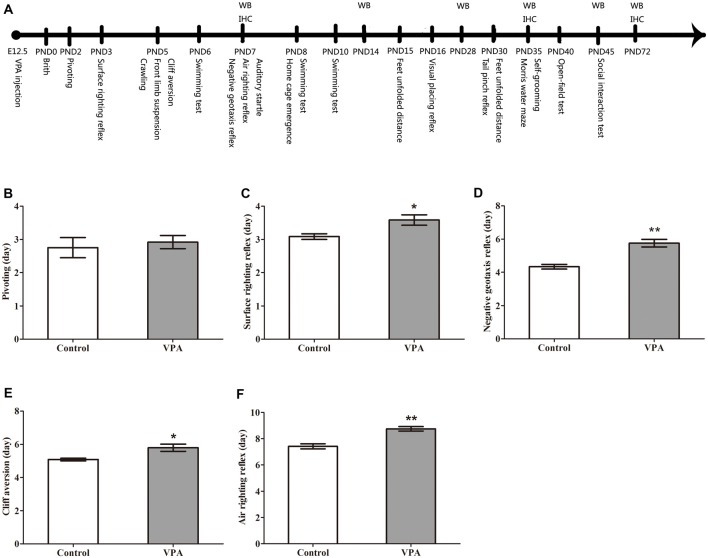
Valproic acid (VPA)-treated rats exhibited delayed nervous reflex development. (A) Experimental approach. A representative timeline of the behavioral tests, western blot (WB) and immunohistochemistry (IHC). (B) VPA-treated rats showed normal performance in the first pivoting appearance day compared to control rats (p > 0.05). (C–F) VPA-treated rats exhibited significantly longer latencies in behavioral ontogeny than control rats, including the first appearance day of surface righting reflex (*p < 0.05), negative geotaxis reflex (**p < 0.01), cliff aversion (*p < 0.05) and air righting reflex (**p < 0.01). Data are represented as mean ± SEM (*p < 0.05, **p < 0.01).